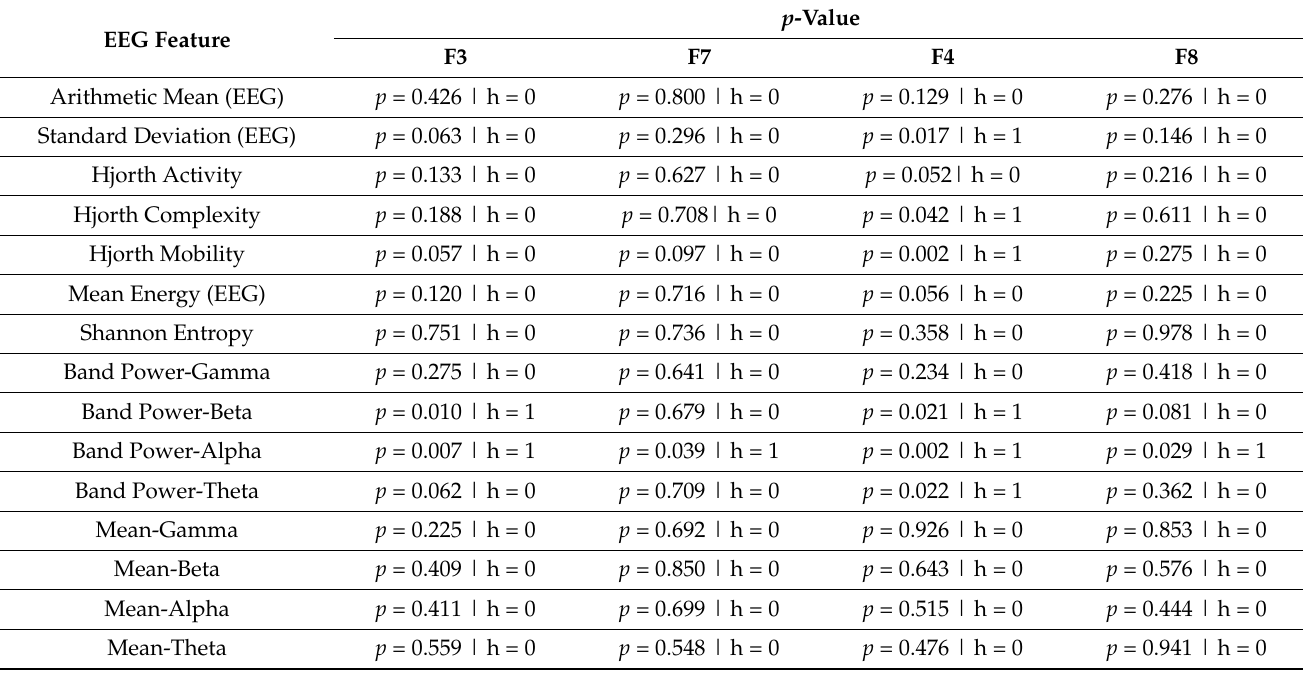
Table 4. The t -test results for EEG features between the memory recall and no-recall data.